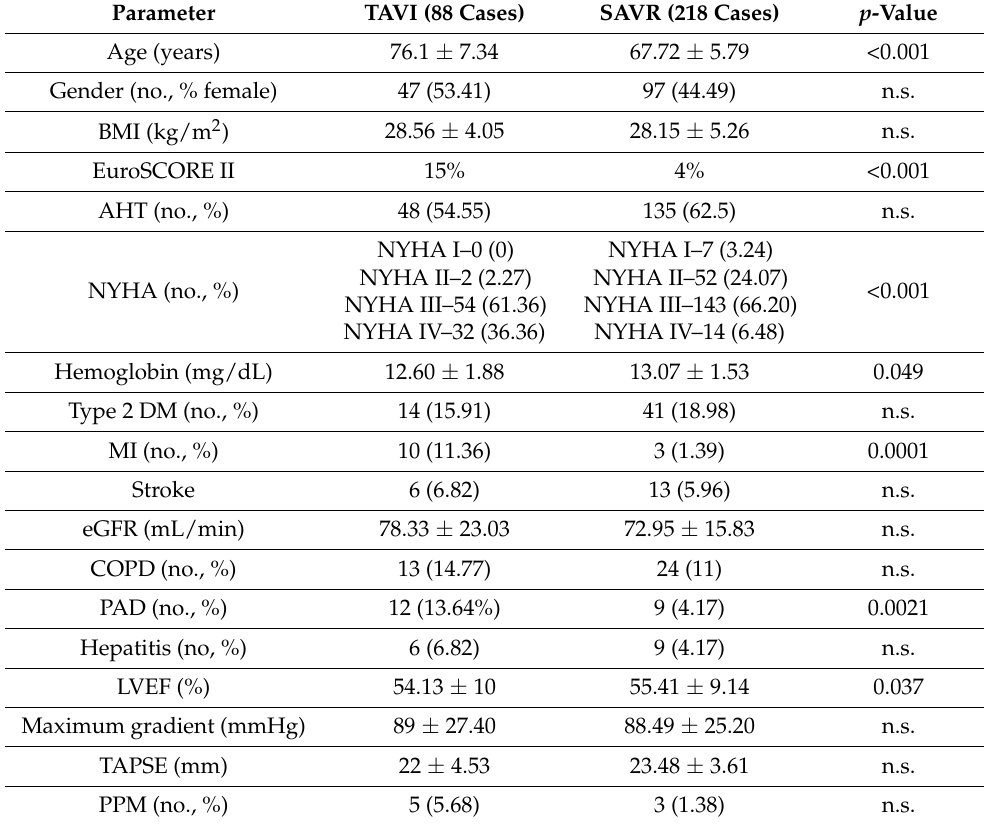
Table 1. General characteristics of the patient